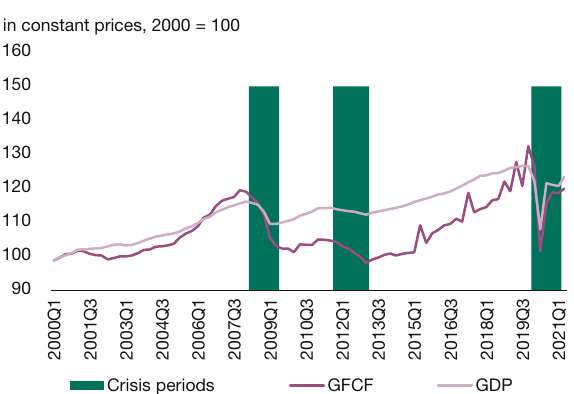
Figure 2 Gross fi xed capital formation in the euro area during COVID-19 and global fi nancial crisis